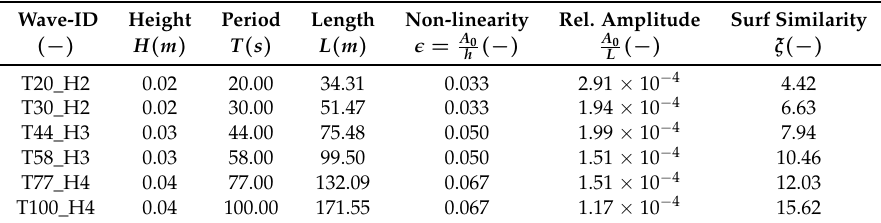
Table 1. Characteristics of sinusoidal waves used, surf similarity according to Equation (5), naming scheme indicates period and wave height, respectively.